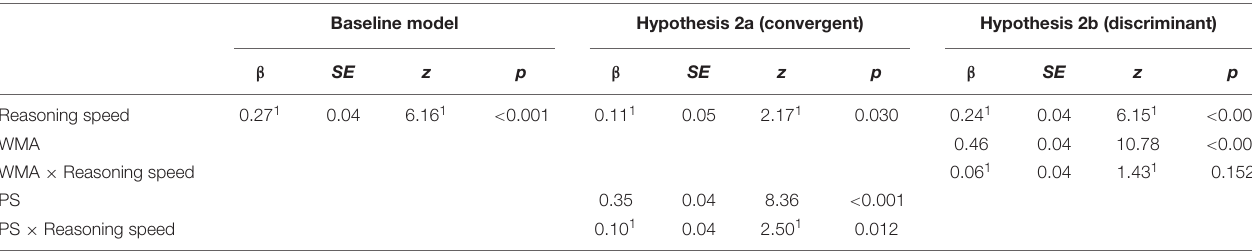
TABLE 2 | Interaction effects of component skills – word meaning activation (WMA) and perceptual speed (PS) – and reasoning speed on reasoning